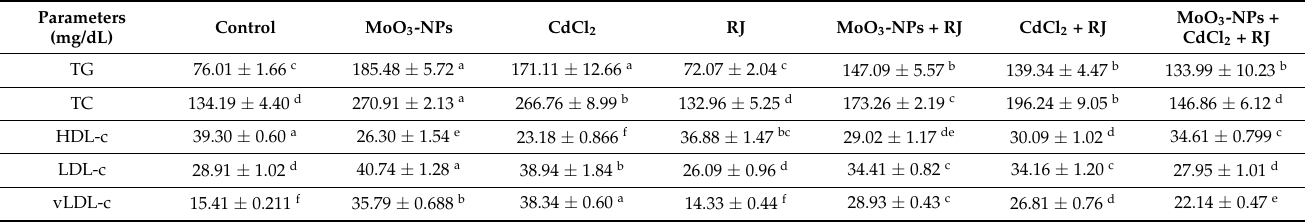
Table 2. The effect of Royal Jelly (RJ) on the serum lipid profile of male rats given molybdenum nanoparticles (MoO 3 -NPs), cadmium chloride (CdCl 2 ), or a combination of the two for 30 consecu- tive days.